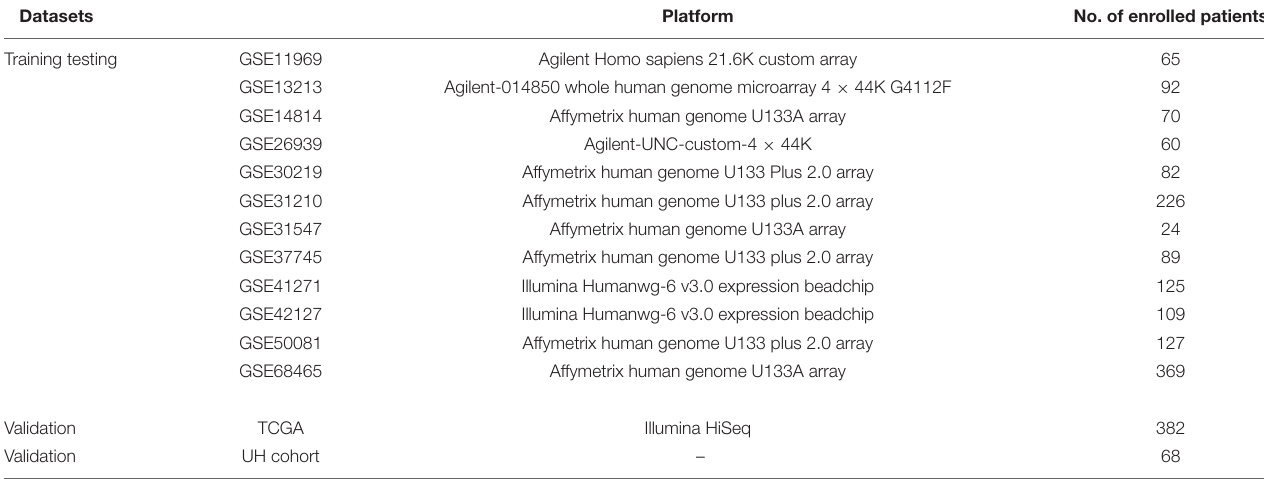
TABLE 1 | Datasets used in this study.